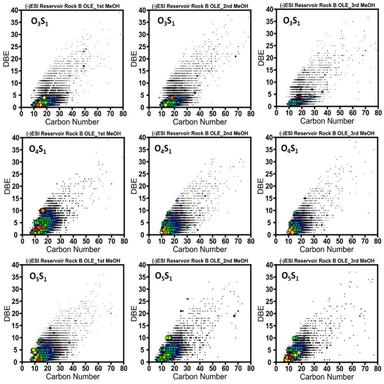
DBE-C# plots of O3-5S1 species in the methanol extracts.